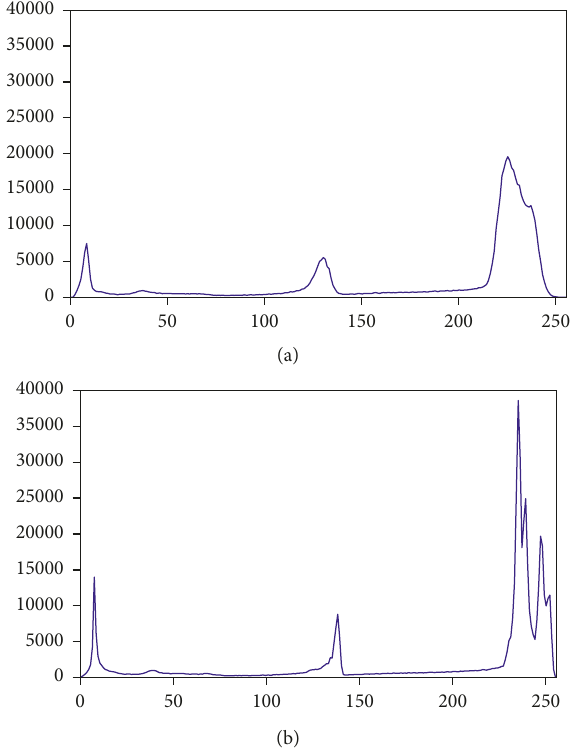
Figure 2: Histograms of (a) normal and (b) abnormal PS.